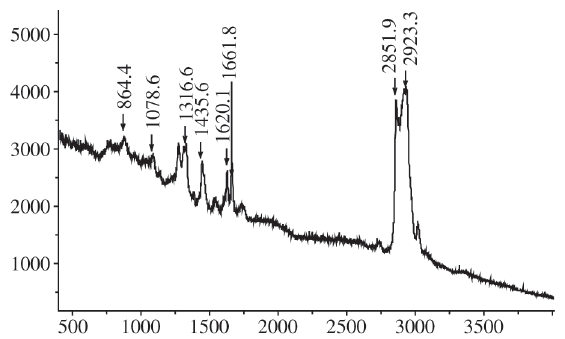
Figure 2. Raman spectrum of polyurethane after cure (NCO/OH =